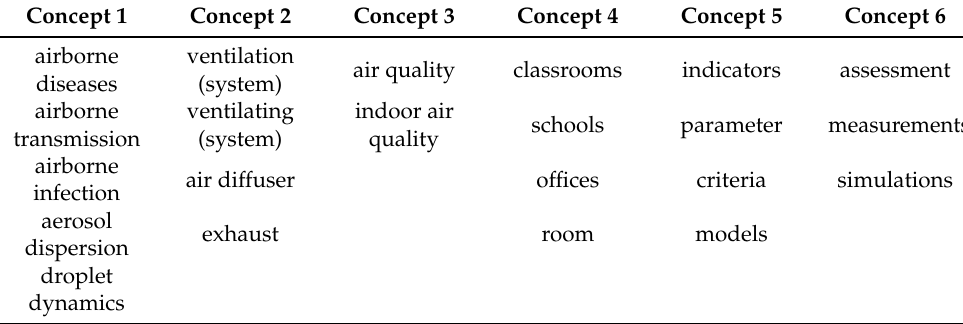
Table 1. Keywords for literature